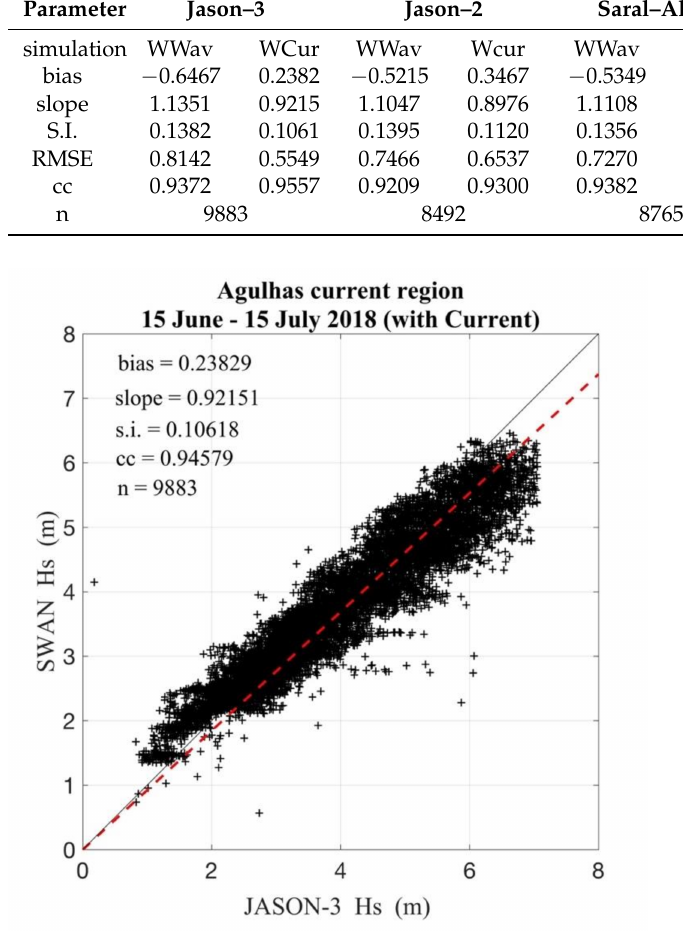
Figure 3. Scatter plot after the collocation of the SWAN model Hs (considering currents) to the altimeter Hs for a six-day period (21 June 2018–27 June